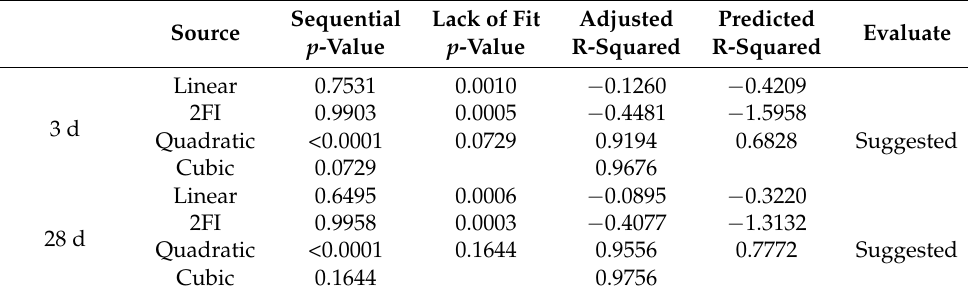
Table 4. Comprehensive analysis of various compressive strength